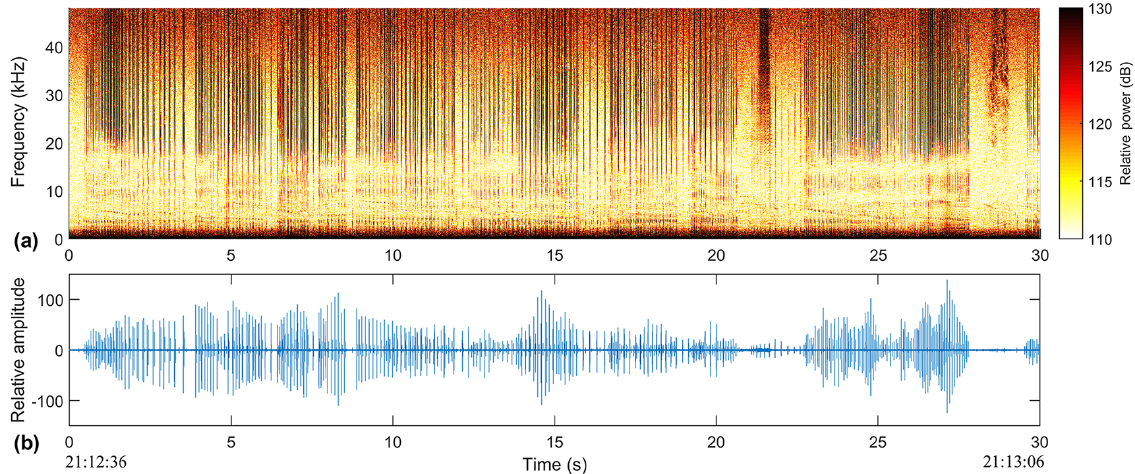
Figure 4. Spectrogram (a) and waveform (b) of 30s of data recorded on channel 1 of file 06 showing dolphin clicks (vertical bars mostly above 15kHz), and burst pulses (mostly above 15kHz between 20–22 and 28–30s). Note that the frequency range is different from the previous plot. Time stamps are local time (CEST) on 9 June 2014. The relative amplitude corresponds to the power in decibels minus the hydrophone sensitivity of − 161.4dB re